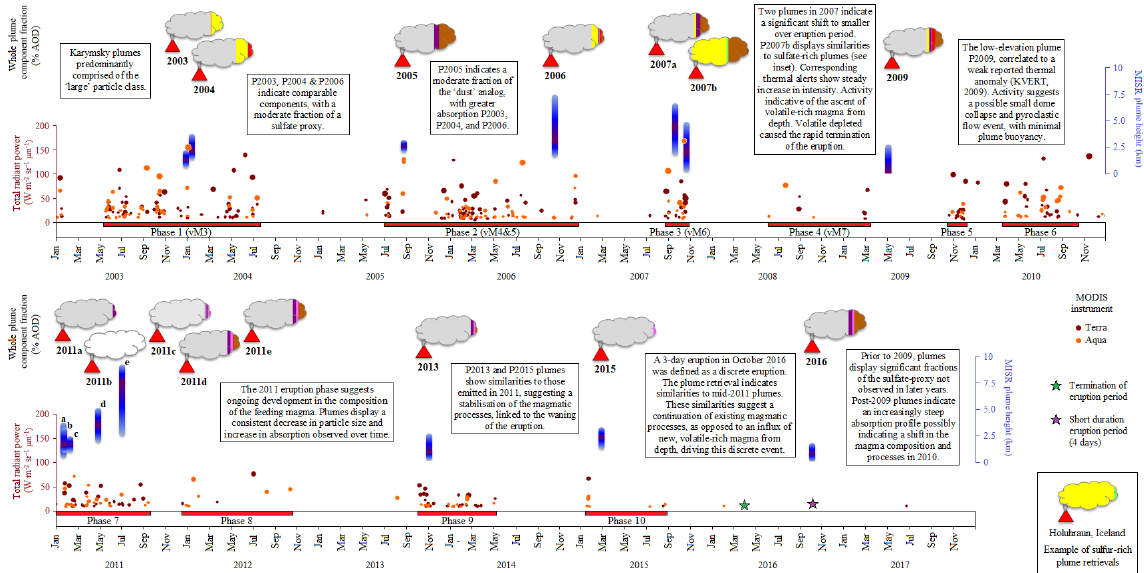
Figure 8. Timeline of volcanic activity at Karymsky volcano. Top row of each panel: MISR research aerosol retrieval algorithm (RA) plume particle component fractions for individual plumes (the colors are identified in Table 2 and the legends of Figs.6 and 7; white indicates no data available). Middle row and right axis: MISR stereo-derived plume heights, indicating exact timing and vertical extent (blue) and vertical distribution of highest contrast elements (purple) for each plume. Bottom row and left axis: thermal anomalies obtained from the MODVOLC hotspot alerts from both the Terra and Aqua MODIS satellite instruments. Horizontal axis: eruption phases defined by MODIS thermal alerts and correlated with phases (vM) defined in the work of van Manen et al. (2012). Inset: plume properties for Holuhraun plume on 25 September 2014 (orbit: 78567; path: 214; blocks: